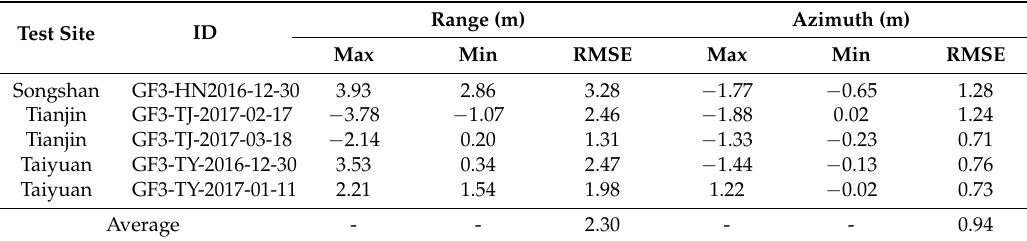
Table 6. Absolute positioning accuracy after conventional field calibration. RMSE: root mean square error.